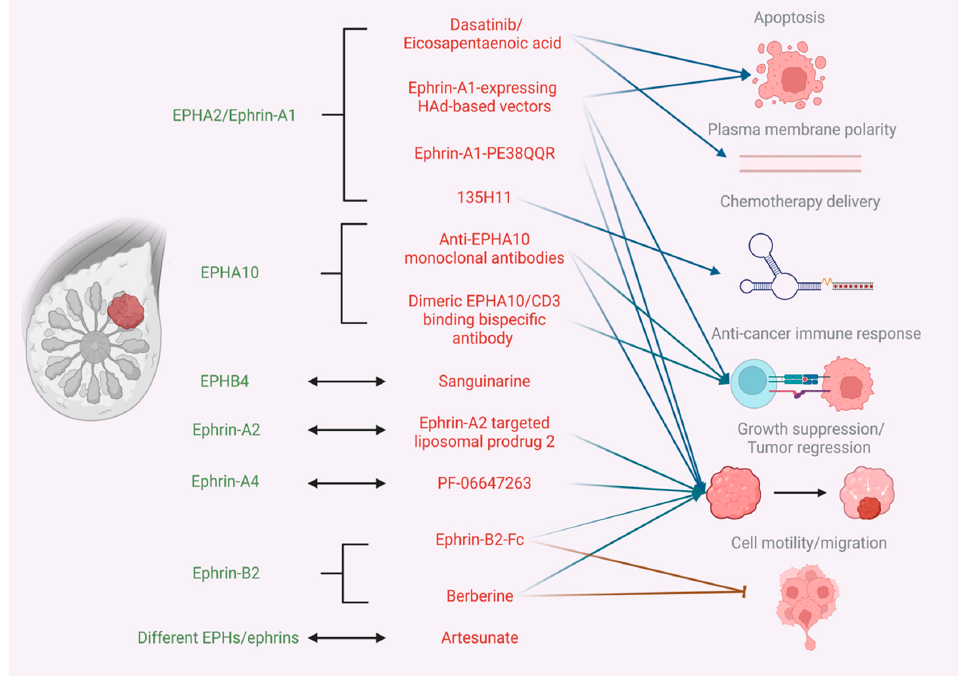
Figure 1. Mechanisms of action of different therapeutic agents targeting the EPH/ephrin system in BC. Created with